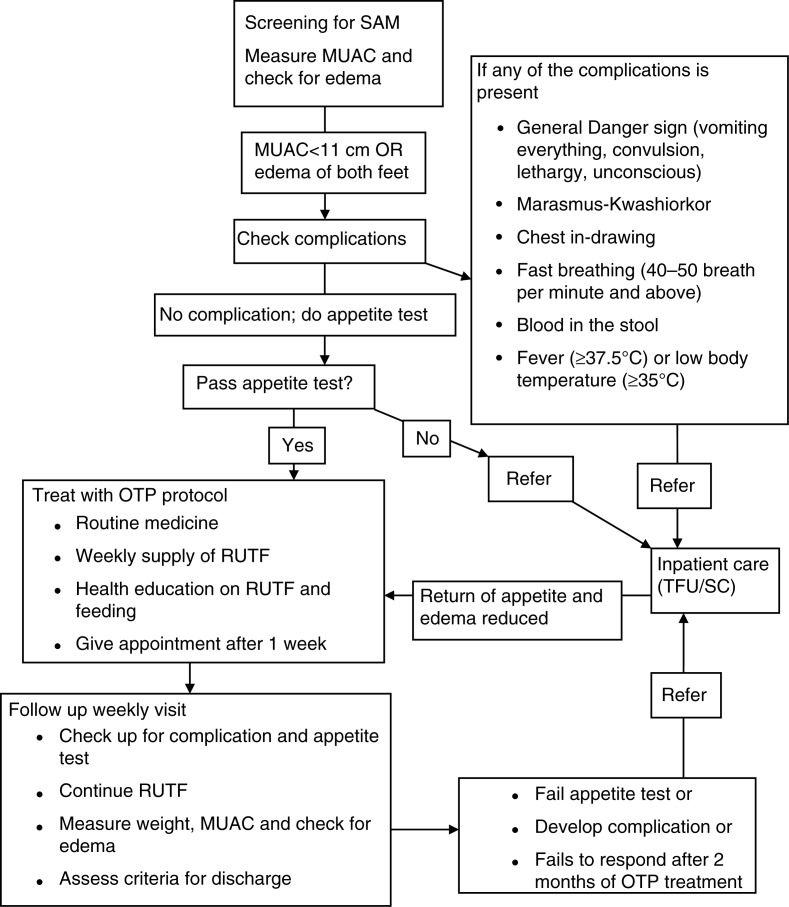
OTP treatment protocol used in the study setting. Children who had MUAC value <11 cm or had edema and had no medical complications and passed appetite test were admitted to OTP. Children in the OTP had weekly follow up for medical checkup, RUTF supply, and anthropometric measurements. Those who developed complications or failed to respond to treatment were referred to inpatient care.